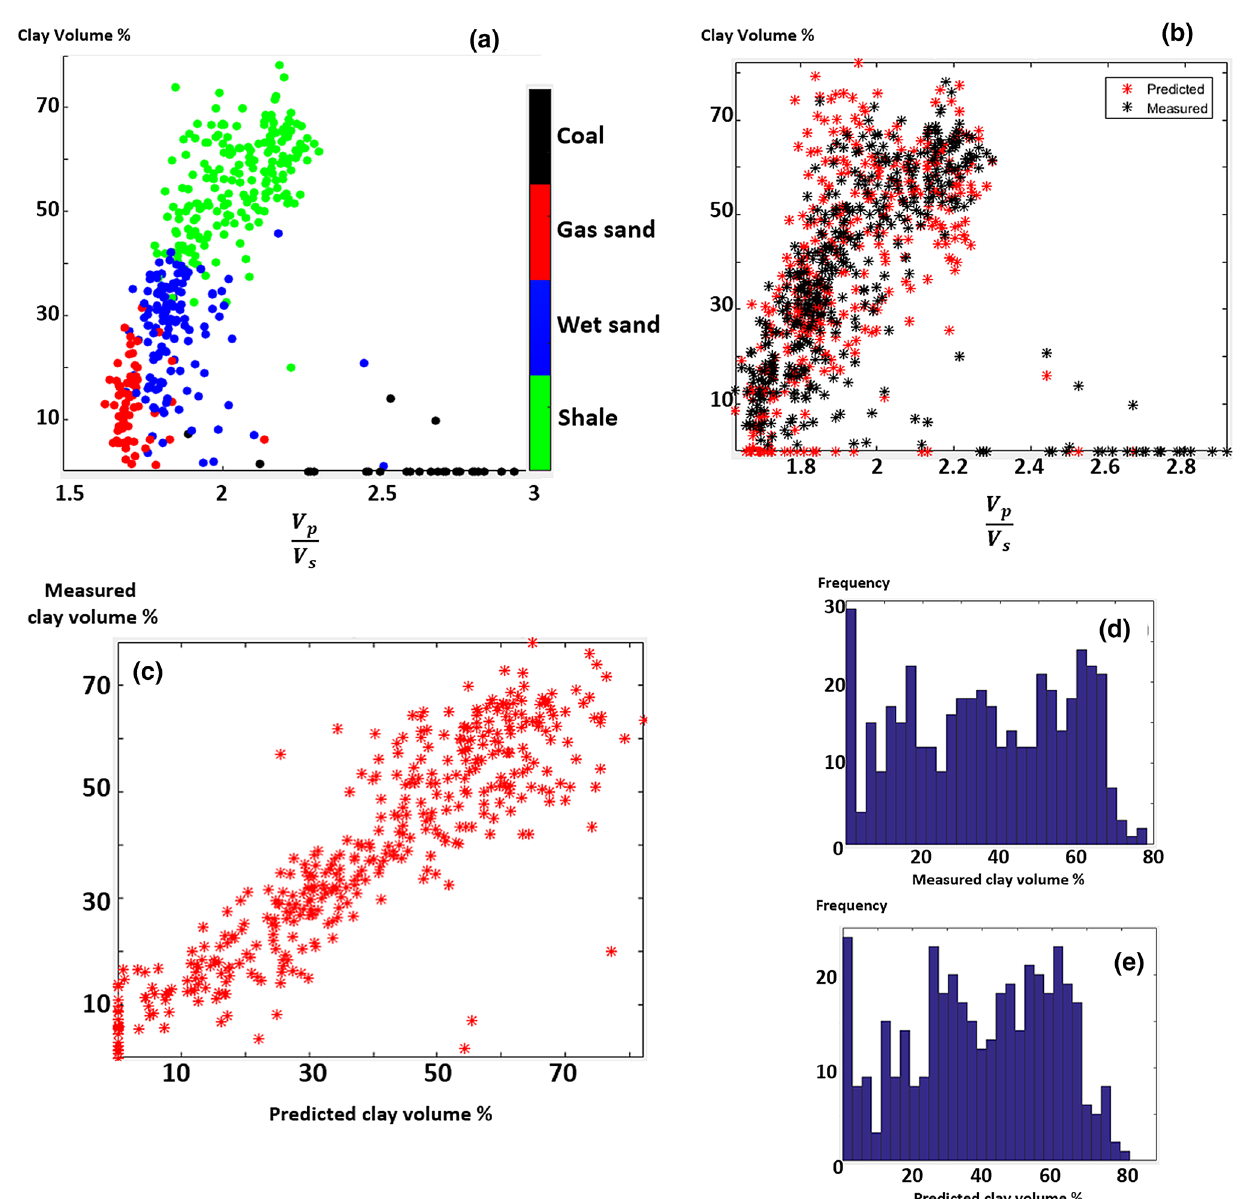
V p Fig. 8 a Cross-plot of V s versus clay volume at well location color coded by lithofacies classes. b Overlay comparison cross-plot of versus clay volume, measured clay volume in black and predicted